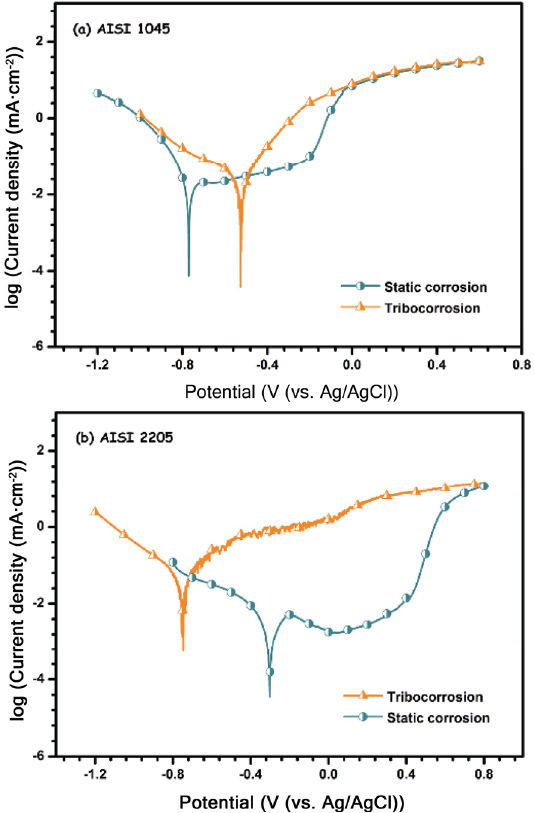
Fig. 4 Potentiodynamic curves of AISI 1045 and AISI 2205 without sliding and under sliding in seawater.